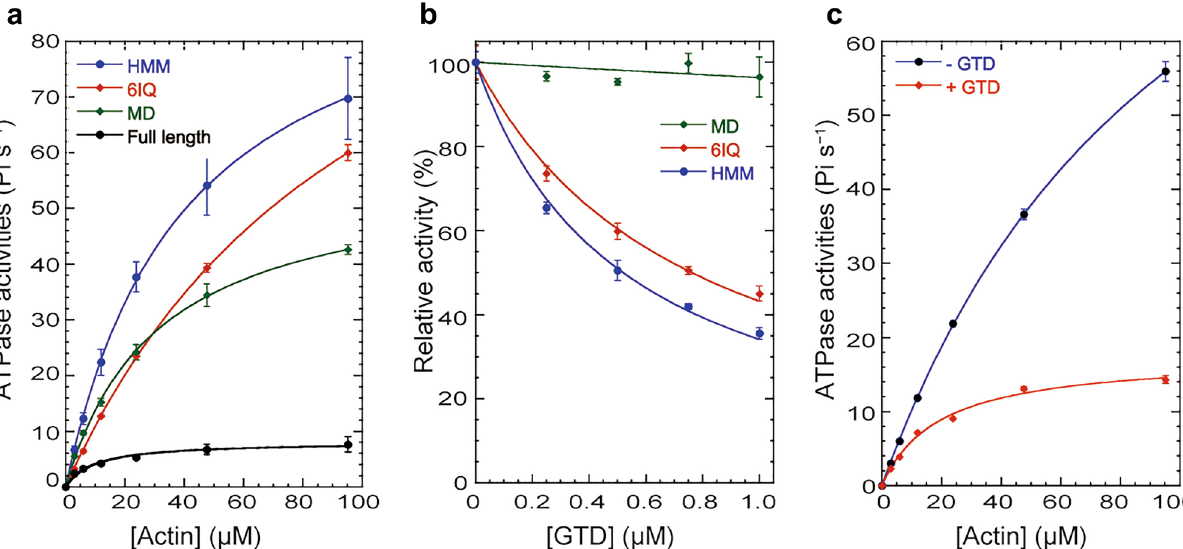
Figure 2. Actin-activated Mg 2+ -ATPase activities and inhibitory effects on Mg 2+ -ATPase activities of Full, HMM, 6IQ, and MD. ( a ) Actin-activated Mg 2+ -ATPase activities of Full, HMM, 6IQ, and MD. Mg 2+ -ATPase activities in the presence of various actin concentrations. The data were fitted using Michaelis–Menten dynamics, and the V max and K app values were measured. The concentrations of Full, HMM, 6IQ, and MD used 0.005–0.019, 0.001–0.009, 0.002–0.018, and 0.001–0.008 µM, respectively. ( b ) Inhibitory effects of GTD on Mg 2+ -ATPase activities of HMM, MD, and 6IQ. The actin-activated ATPase activities of HMM and 6IQ in the presence of various concentrations of GTD and 23.8 μM actin were fit to a hyperbola, and the K i values of GTD for HMM and 6IQ were calculated to be 0.5 μM and 0.8 μM, respectively. ( c ) Inhibitory effects of Mg 2+ -ATPase activities of 6IQ by 1 µM GTD in the presence of various actin